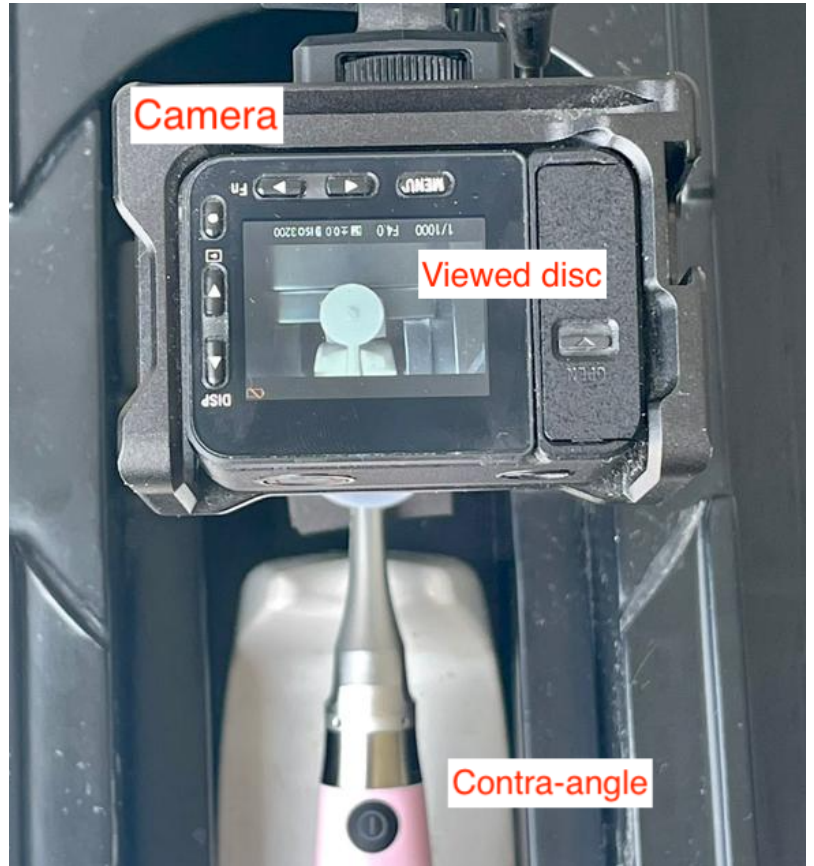
Figure 5. The defined experimental scenario for the algorithm in a top-view perspective, presenting the employed camera, the disc and the